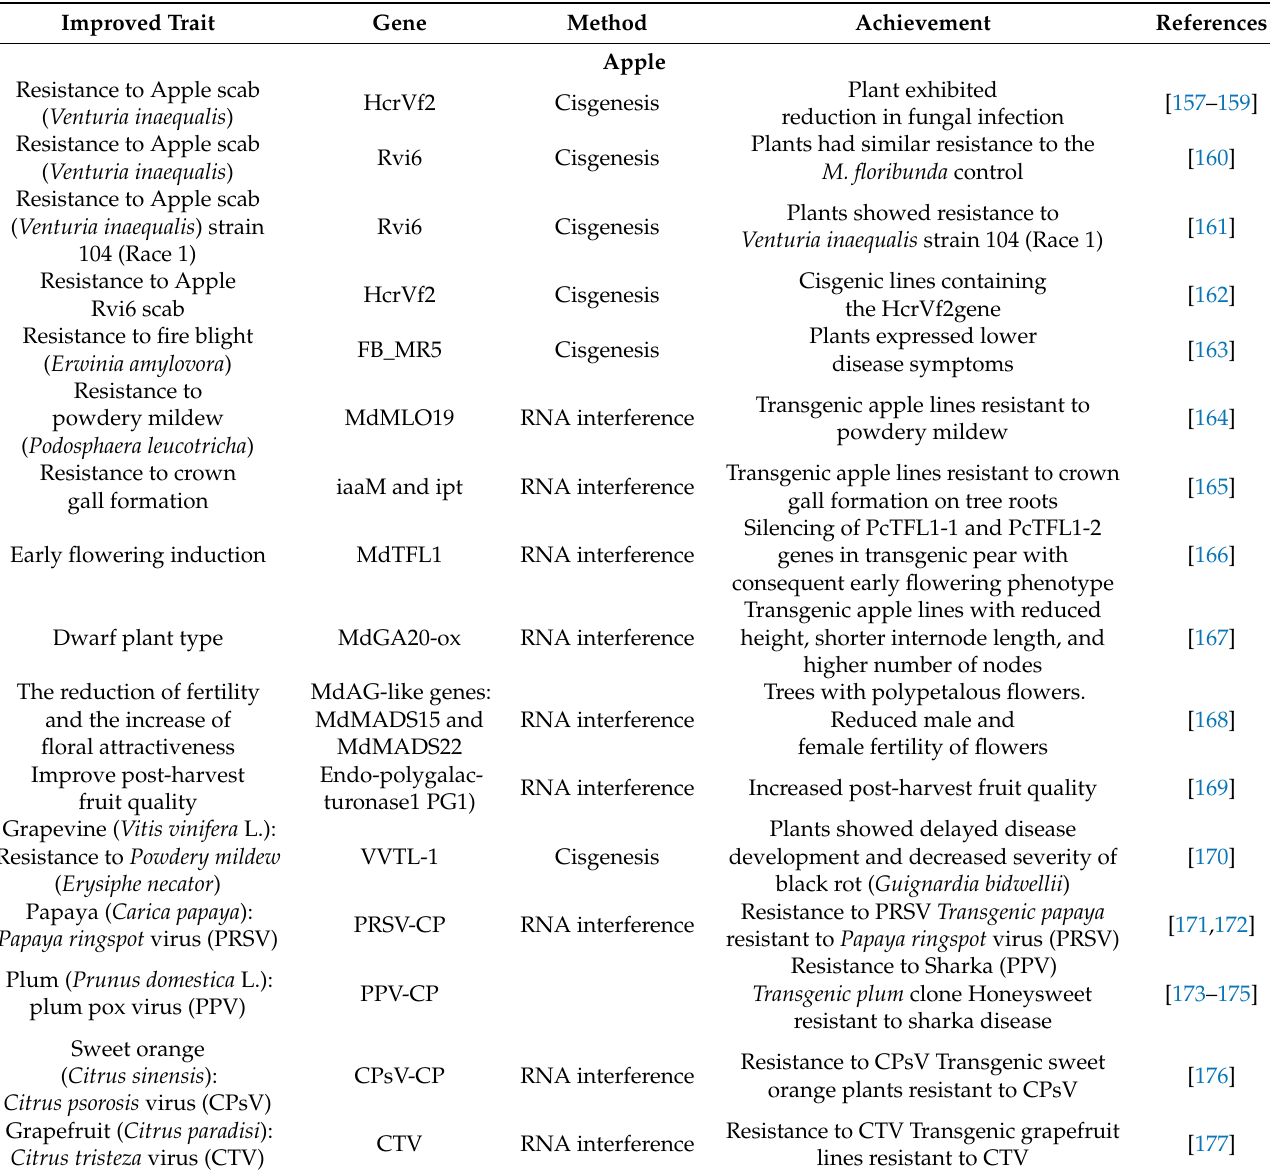
Table 2. Development of genetically engineered fruit crops for functional traits